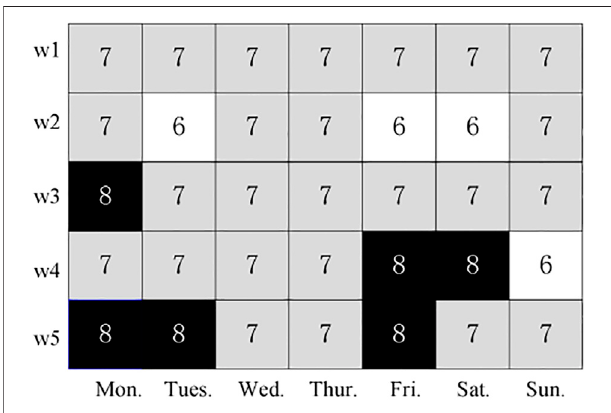
FIGURE 7 | Number of decomposed subsequences of